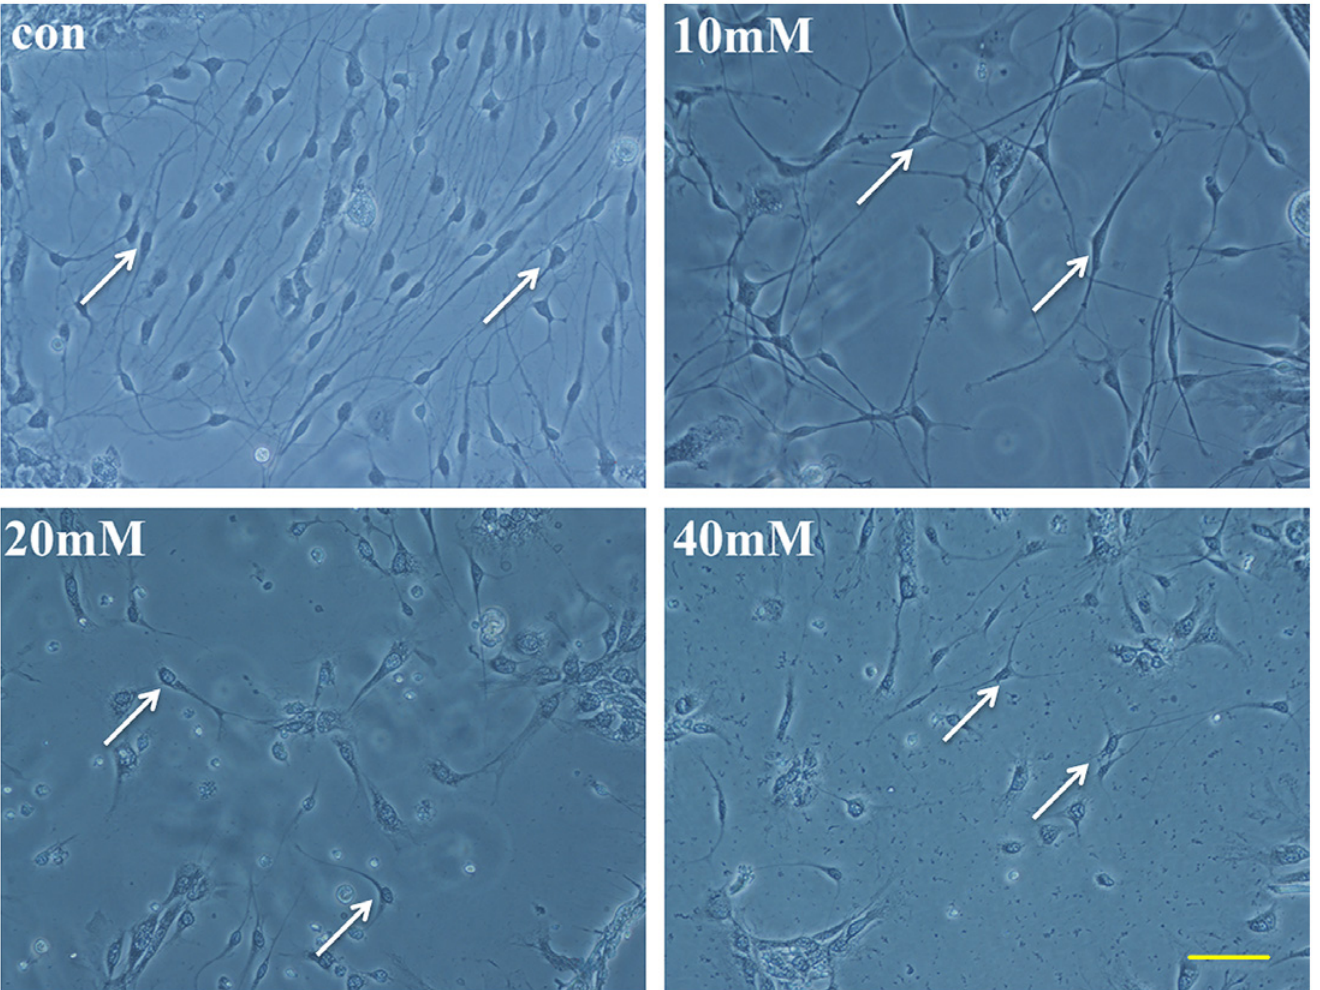
Fig 1. The morphology of SGNs in different interventions in stereoscopic microscope. Glu and two inhibitors were added to the SGNs in integrated medium. In addition to the control group, the drugs that were added to the cultured SGNs included 20 mM Glu, 20+PD150606 and 20+Z-VAD-FMK. Morphological changes were clearly observed in the four groups. The neurites of the SGNs were counted by Image-Pro Plus IPP with the scales. Scale bar = 100 μ